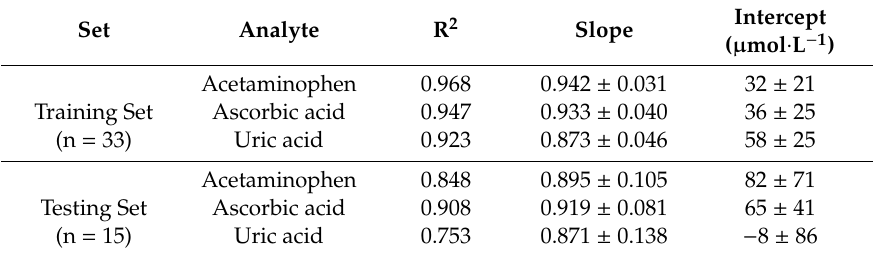
Table 4. Results of the fitted regression curves for obtained vs. expected values, for the training and testing subsets of samples and the three considered compounds (intervals calculated at the 95% confidence level) for the previous works